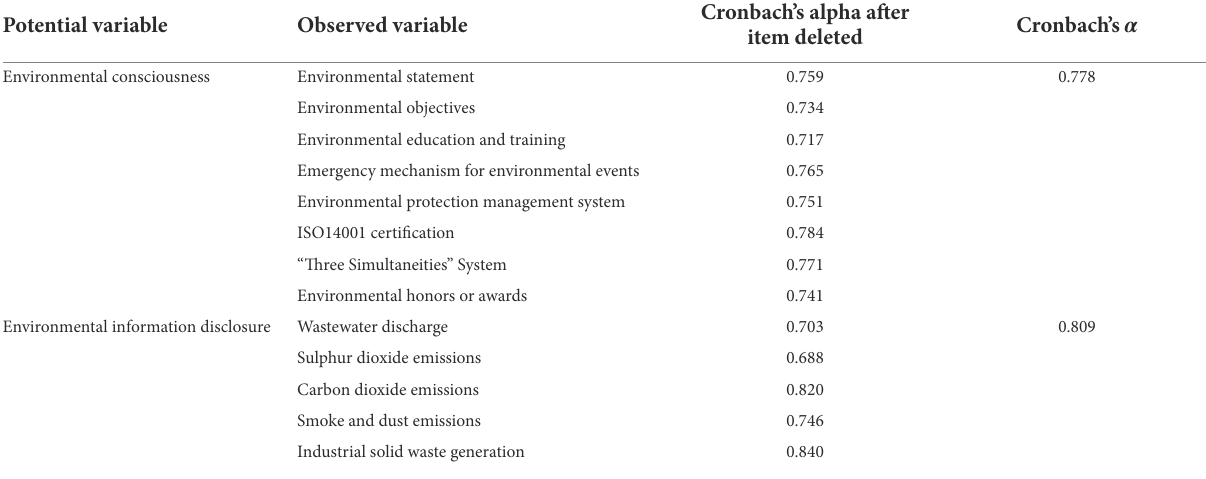
TABLE 3 Reliability test of the scale. Potential